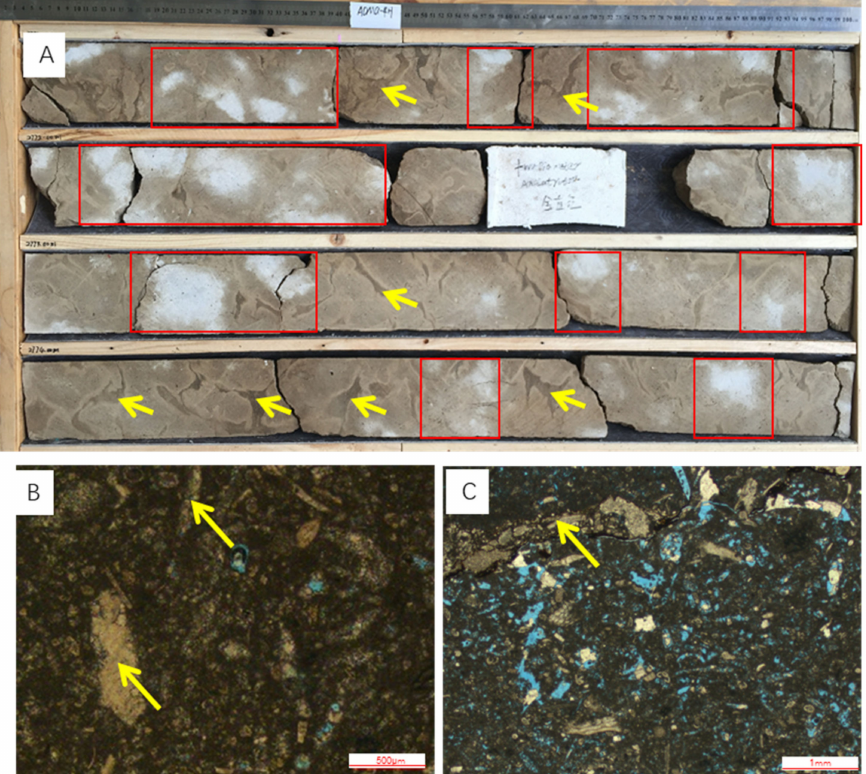
Figure 3. The white patches and burrows on cores and thin sections from the Mi4 member. ( A ) The white patches and burrows on cores; the white patches are shown in the red box and the burrows are shown by the yellow arrow; ( B ) image of a thin section from the white patch; there is intensive cementation by calcite; ( C ) image of a thin section from the boundary between a burrow and host rock; the burrow is filled by echinoderm packstone, marked by a yellow